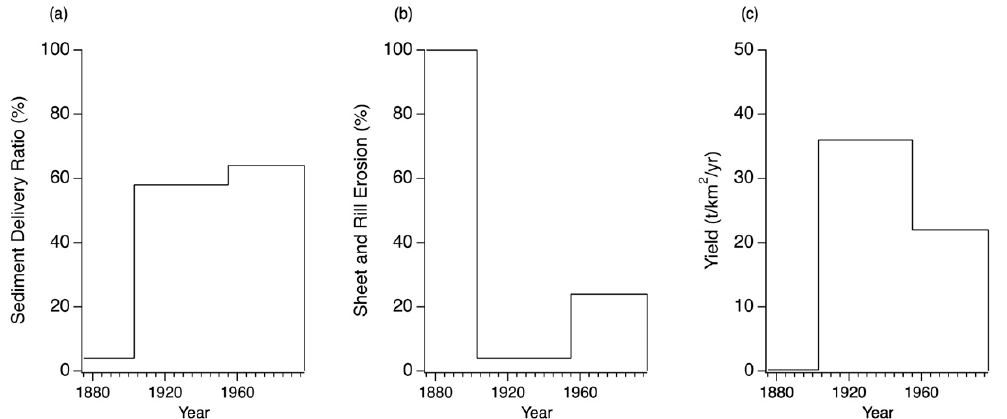
Figure 7. History of ( a ) SDR, ( b ) proportion of sheet and rill erosion, and ( c ) yield in the Takalarup Creek catchment.